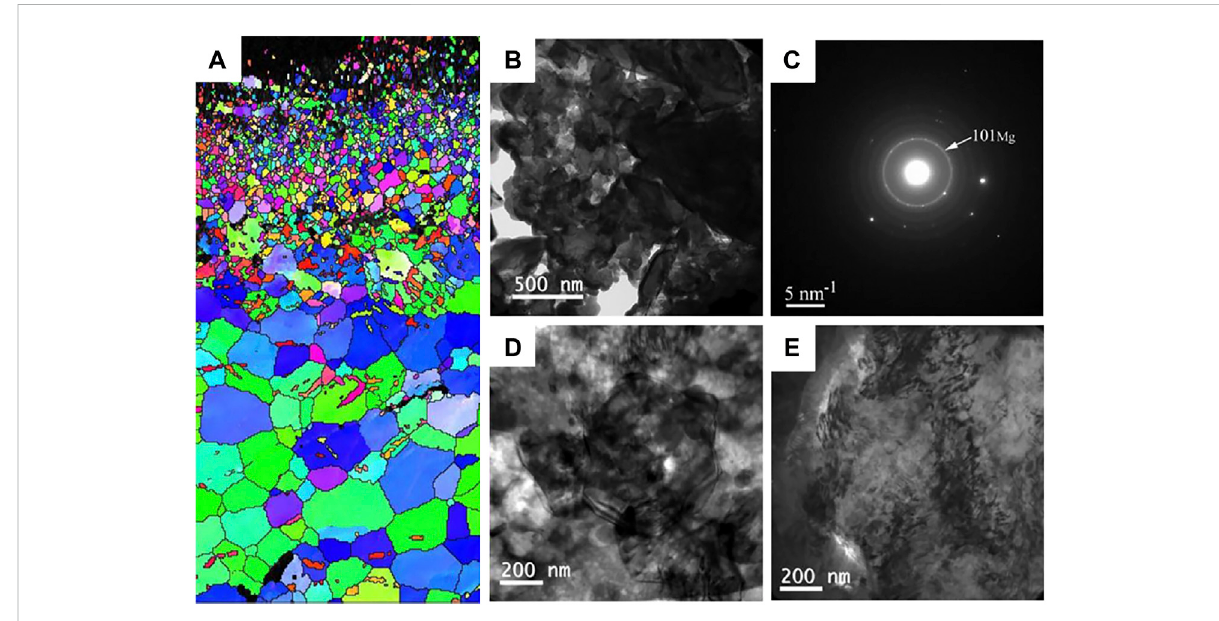
FIGURE 9 (A) EBSD map of the cross section of AZ31 samples after shot peening; TEM images (B) bright fi eld image and (C) the corresponding SAED pattern of the shot peening sample just under the topmost layer, bright fi eld images at the depth of (D) 30 μ m and (E) 150 μ m. Reprinted with permission from reference (Bagherifard et al., 2018; Bagherifard et al., 2019),